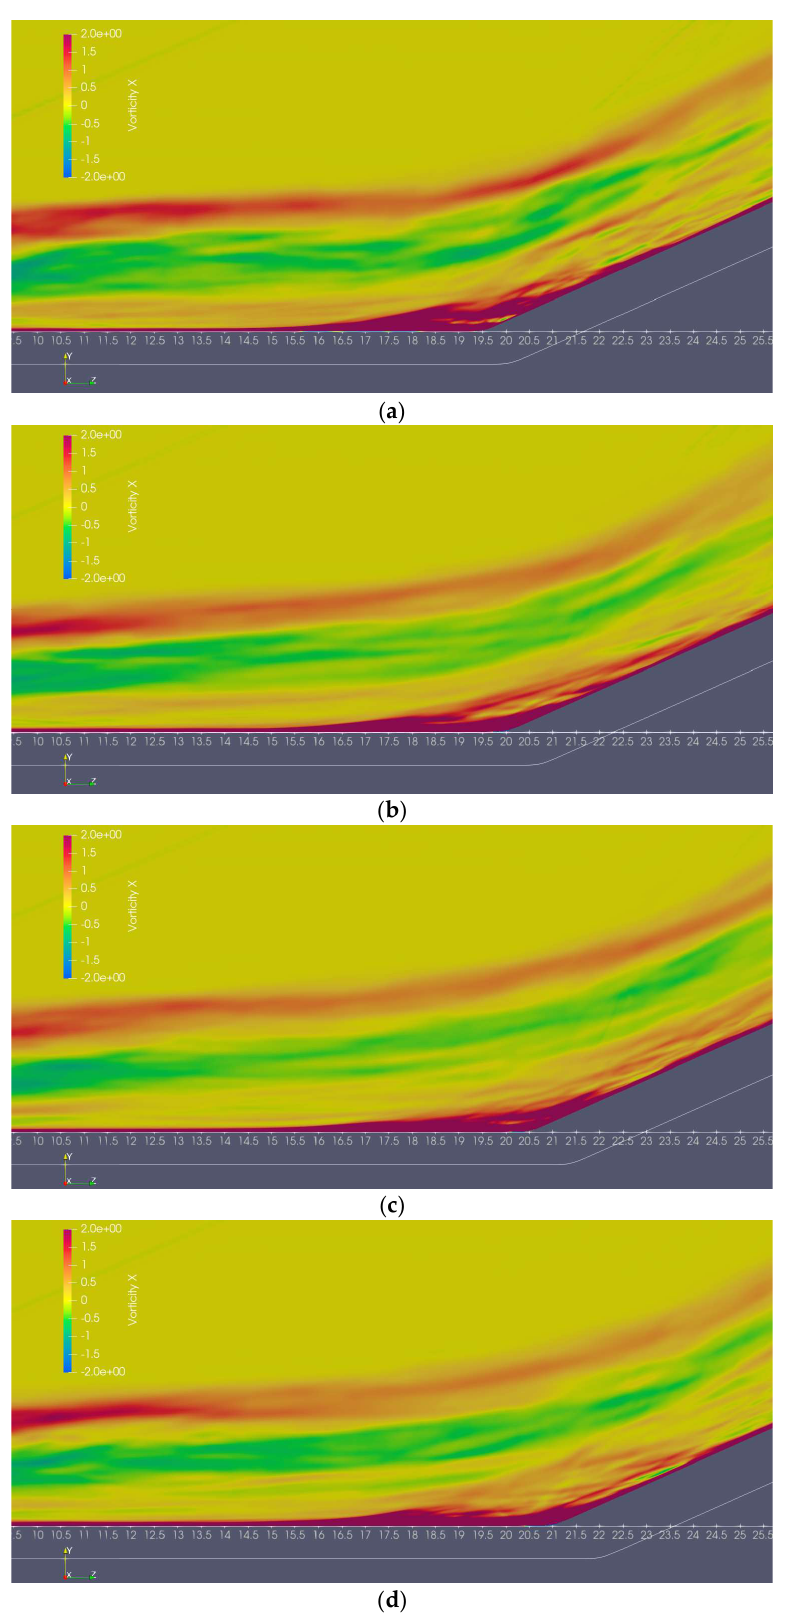
Figure 9. In time-average view, the vorticity distribution on the streamwise central plane, ( a ) case 1, ( b ) case 2, ( c ) case 3, ( d ) case